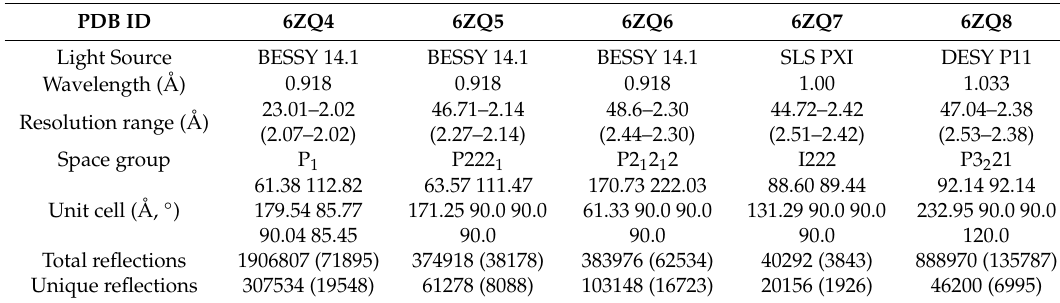
Table 1. Data collection and refinement statistics. Statistics for the highest-resolution shell are shown in